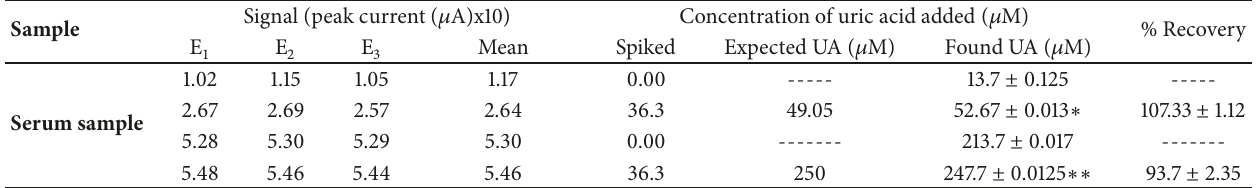
Table 2: Accuracy of UA detection with the developed sensor evaluated through determination of percent recovery. Signal (peak current ( 𝜇 S ample